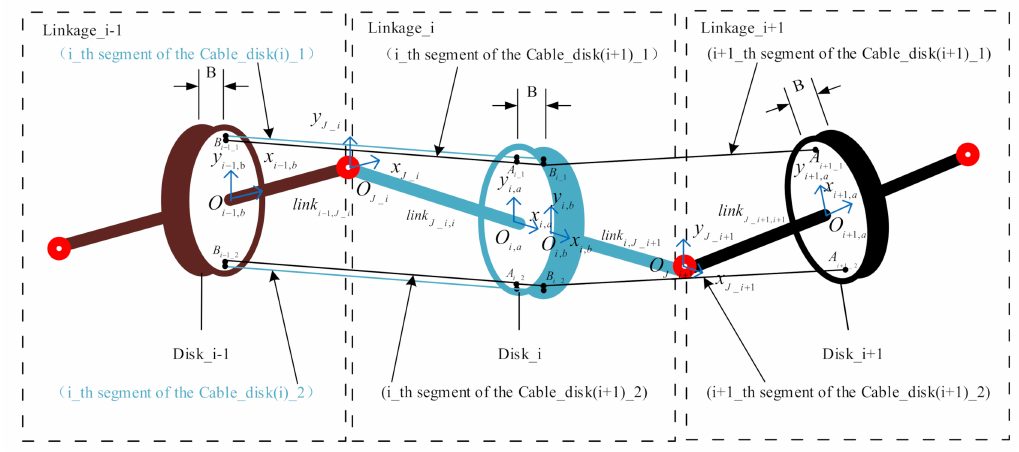
Figure 2. Kinematic relationships of adjacent units of the